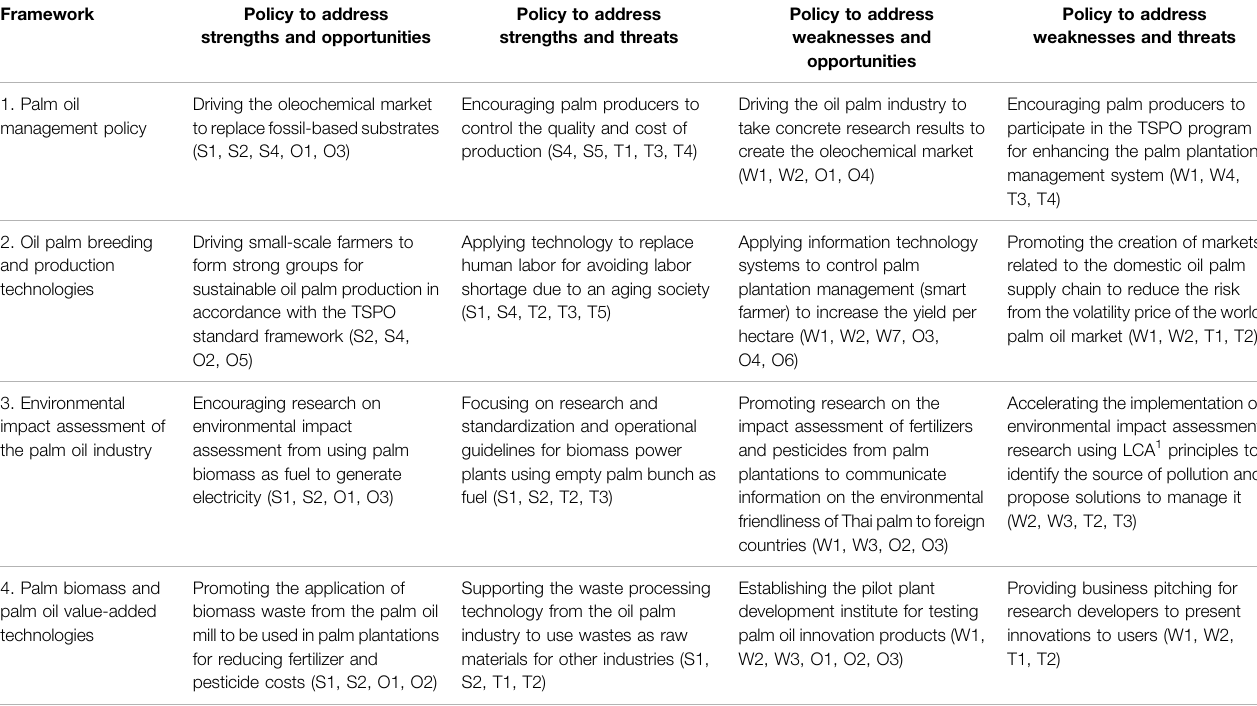
TABLE 6 | TOWS matrix applications to the future research framework palm oil supply